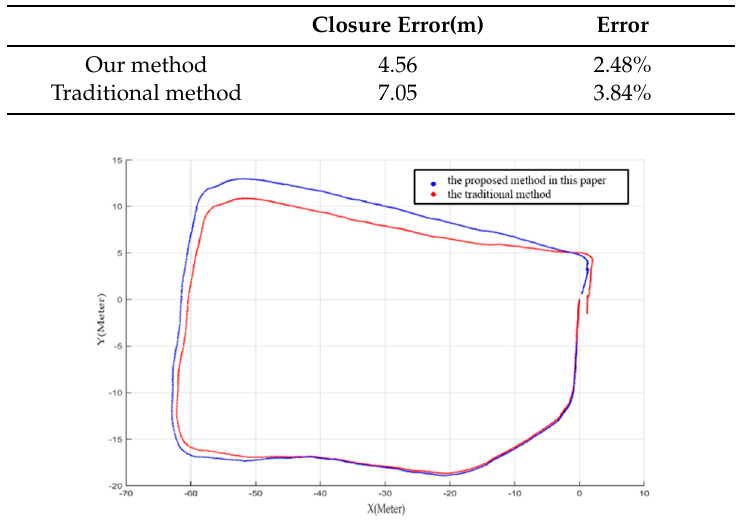
Figure 8. Estimated rover paths from the two BA methods. Red and blue curves represent the estimated trajectory using the traditional method and the proposed method, respectively.